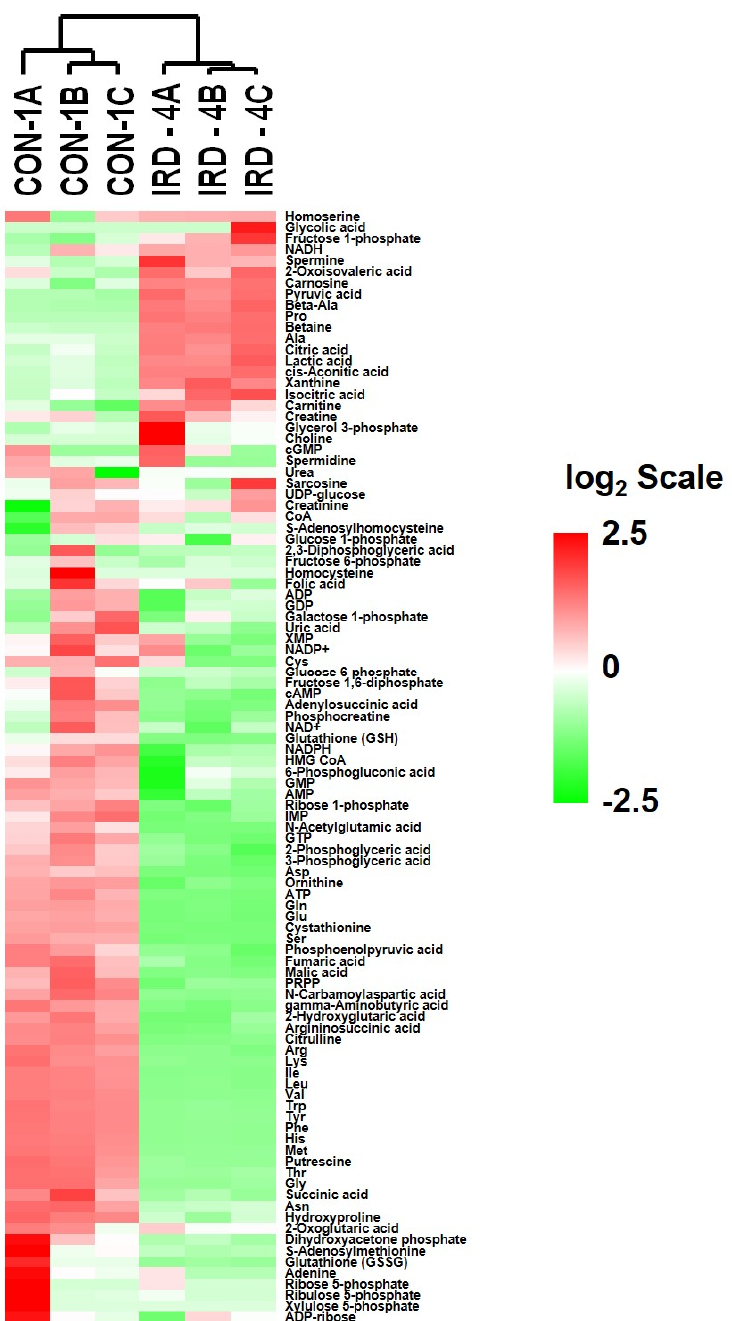
Figure 3. Metabolite expression heat Map related to control and senescent HCT-116 cells. CON-1A, CON-1B and CON-1C are triplicate samples of control (non-IR) while IRD-4A, IRD-4B and IRD-4C are triplicate samples of 20 Gy IR-induced senescent cells. The heat map shown is an agglomerative clustering of 100 metabolites. Mean centered logarithmic values of the abundances and clustering is determined by average linkage algorithm and correlation as distance metric.